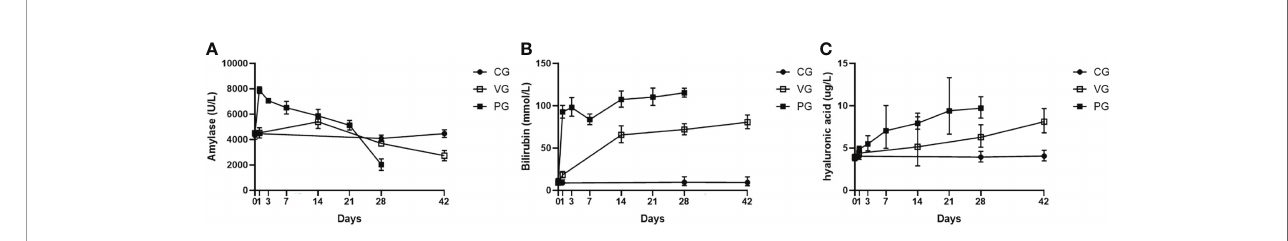
FIGURE 3 | Serum biochemical indices and pancreatic proportion of mice in CG, VG, and PG. (A) Serum amylase (U/L). (B) Bilirubin level in serum (mmol/L). (C) Hyaluronic acid ( m g/L). PG, retrograde pancreatic duct injection group; VG, tail vein injection group; CG, control